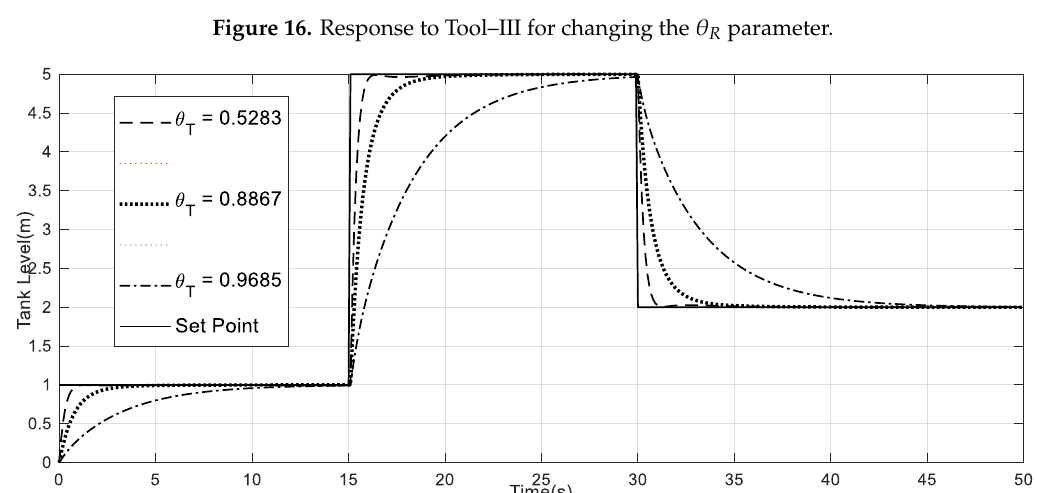
Figure 17. Response to Tool III for changing the θ T parameter.